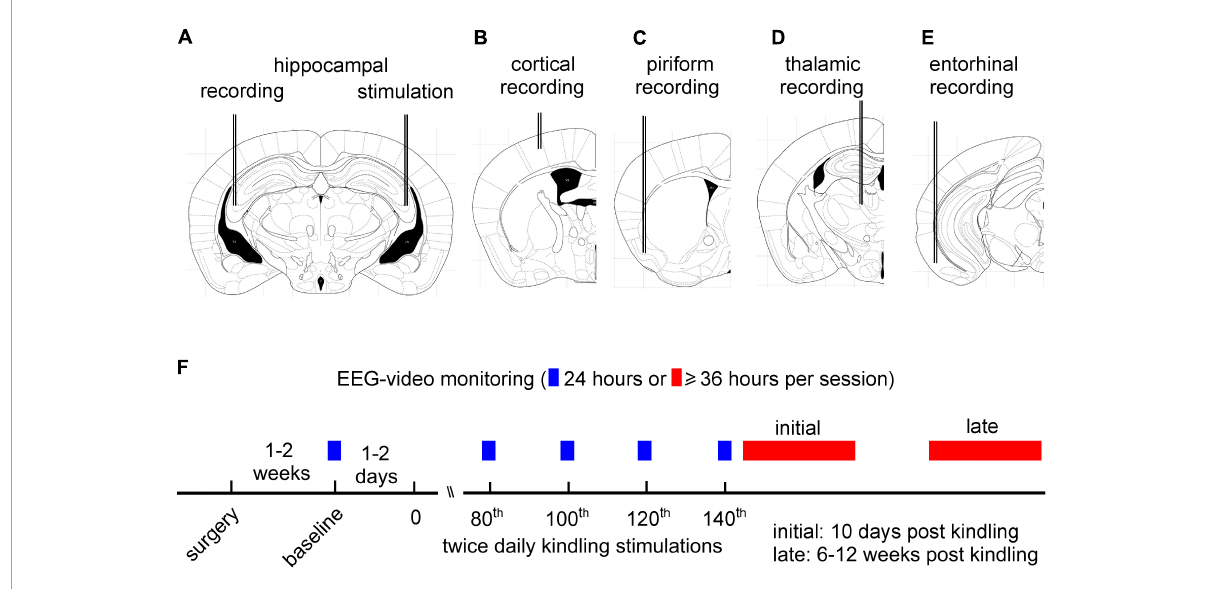
FIGURE1 Schematic layout of intracranial electrode implantation and experimental design. (A–E) Schematic presentations of implanted intracranial electrodes in five groups of mice. Each mouse received implantation of two pairs of bipolar electrodes. The first electrode pair was placed at the hippocampal CA3 region to deliver kindling stimuli and obtain local recordings. The second electrode pair was positioned at unstimulated hippocampal CA3 (A) , parietal cortex (B) , piriform cortex (C) , dorsomedial thalamus (D) , or entorhinal cortex (E) for electroencephalography (EEG) recordings. (F) A schematic layout of extended kindling and EEG-video monitoring experiments. Hippocampal kindling stimulations were applied twice daily, and EEG-video monitoring for 24 h was conducted following 80, 100, 120, or 140 stimulations. Kindling was terminated if ≥ 2 spontaneous recurrent seizures (SRS) events were detected in the 24 h period. Continuous EEG-video monitoring for ≥ 36 h per session were performed within 10 days (initial period) or 6–12 weeks (late period) after termination of kindling